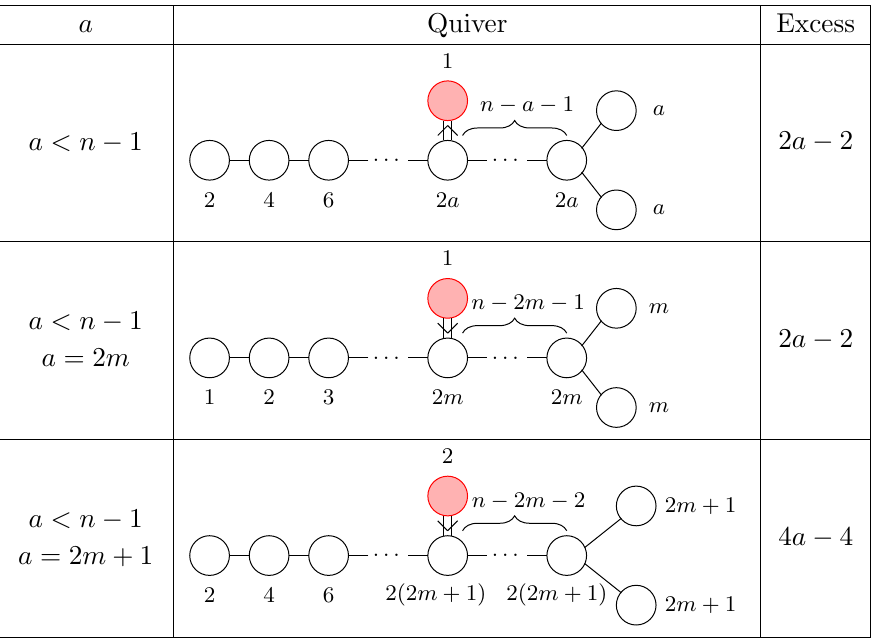
Table 14 . Exotic minimally unbalanced quivers with G = SO(2 n ) and a double laced